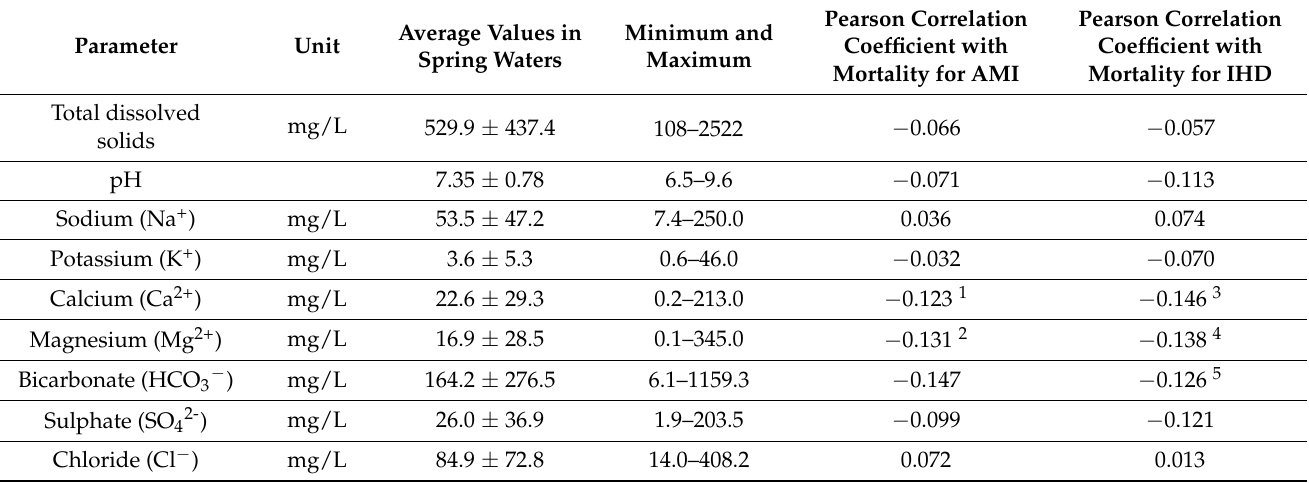
Table 2. Correlations between physico-chemical characteristics of Sardinian waters and mortality for acute myocardial infarction (AMI) and other ischemic heart diseases (IHD).